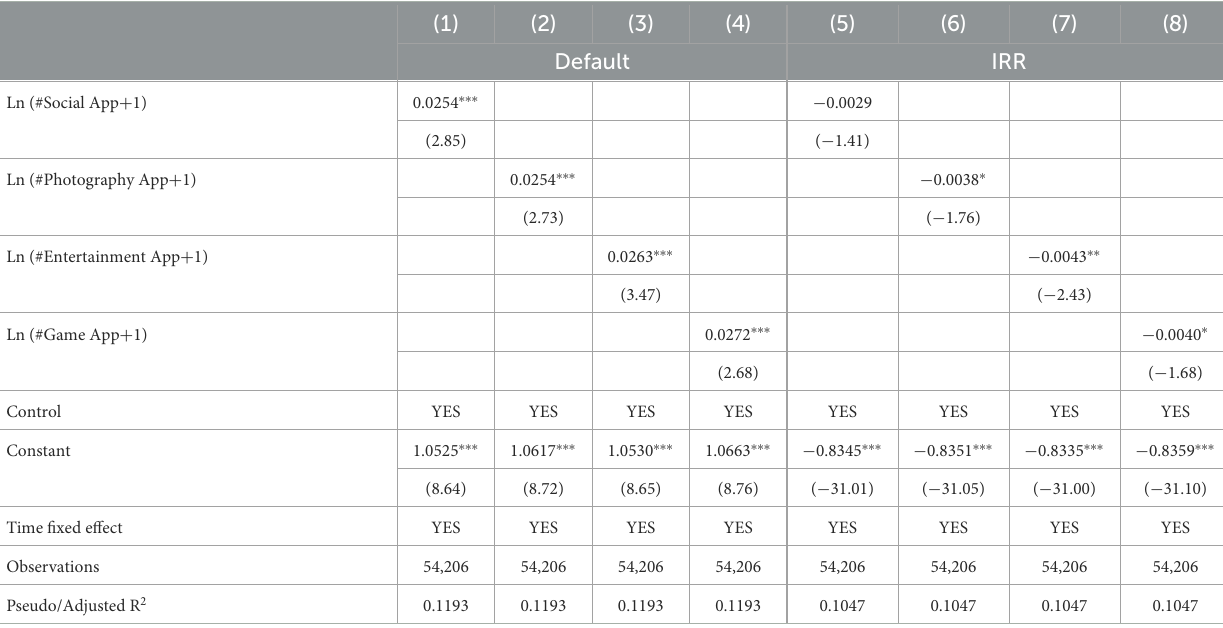
TABLE 5 Relationships between different categories of entertainment apps and investment